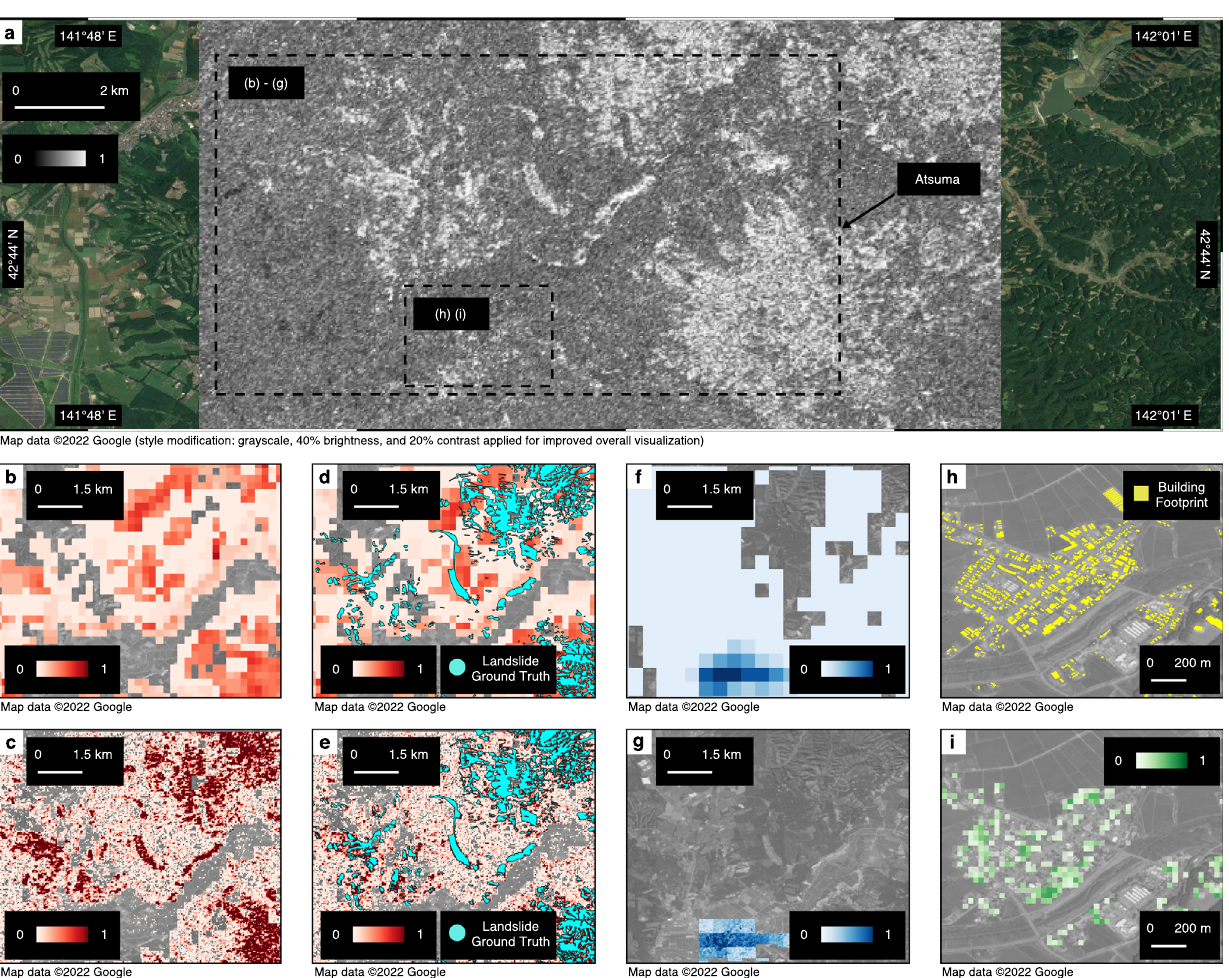
Fig.4|Geospatialpriorandposteriorestimationmodelsofthe2018Hokkaido, Japan earthquake. a Damage proxy map (30-m resolution) with rectangular extentsofeachfocusedarea. b Priorlandslideestimates. c Ourlandslideestimates. d Prior landslide estimates (in red) with ground truth observations (in blue